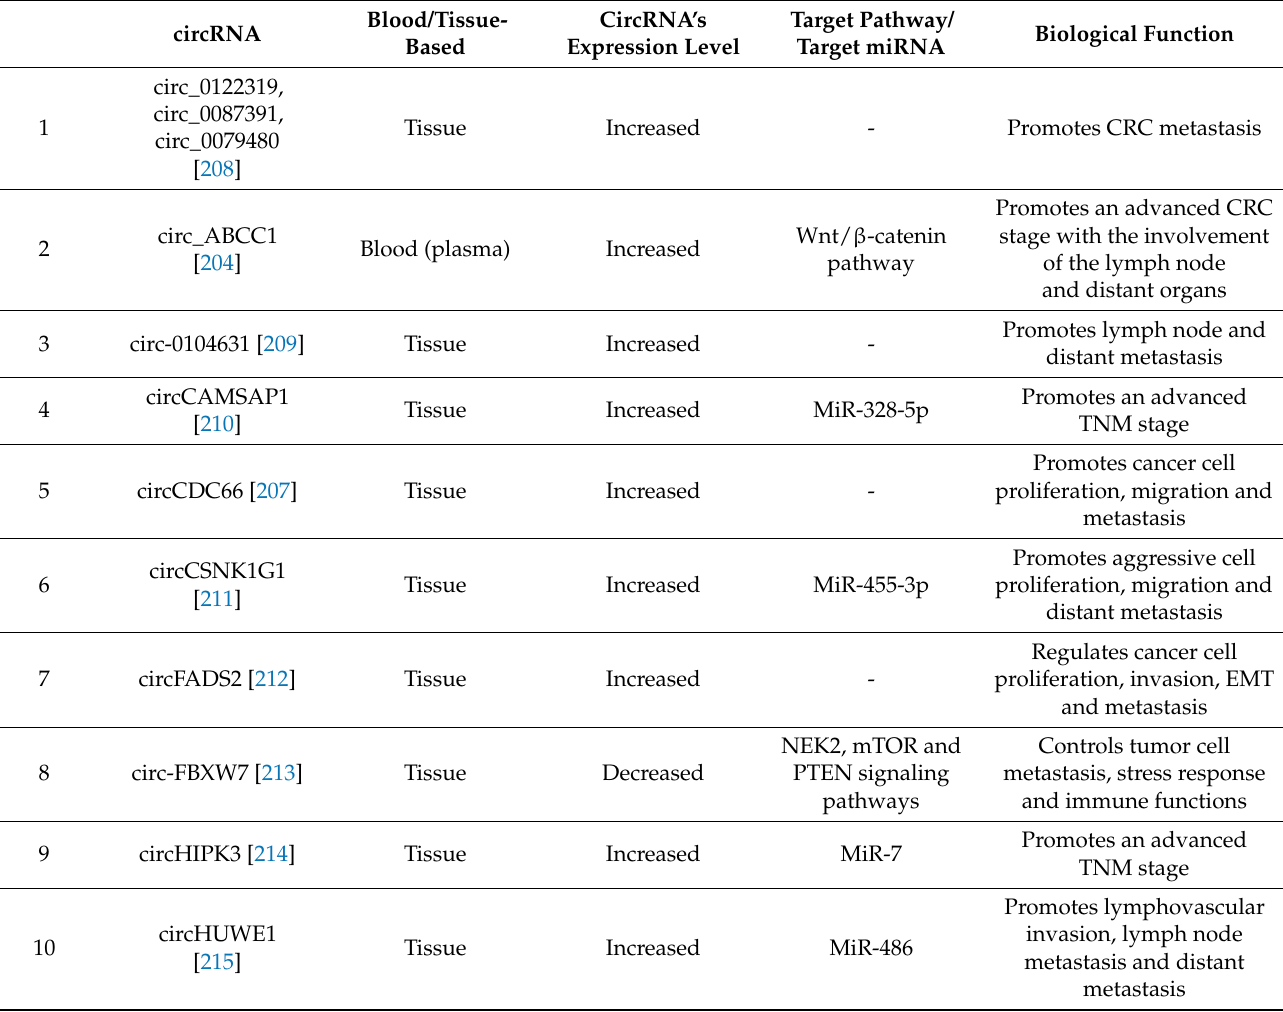
Table 3. Proposed prognostic biomarkers in metastatic colorectal